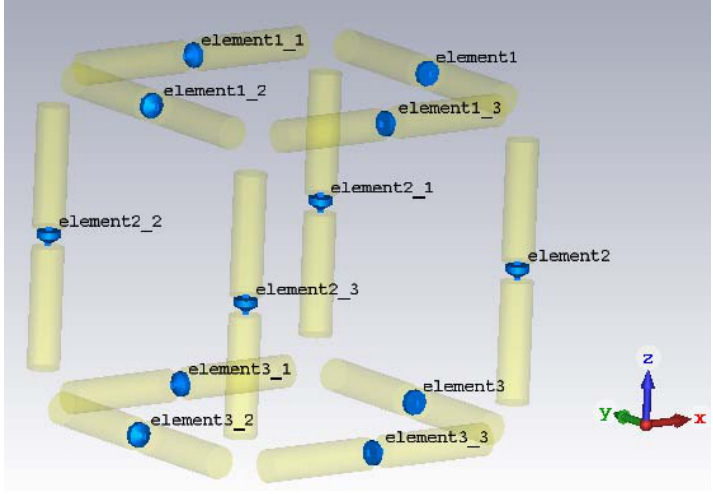
Figure 25. Vector antenna element.